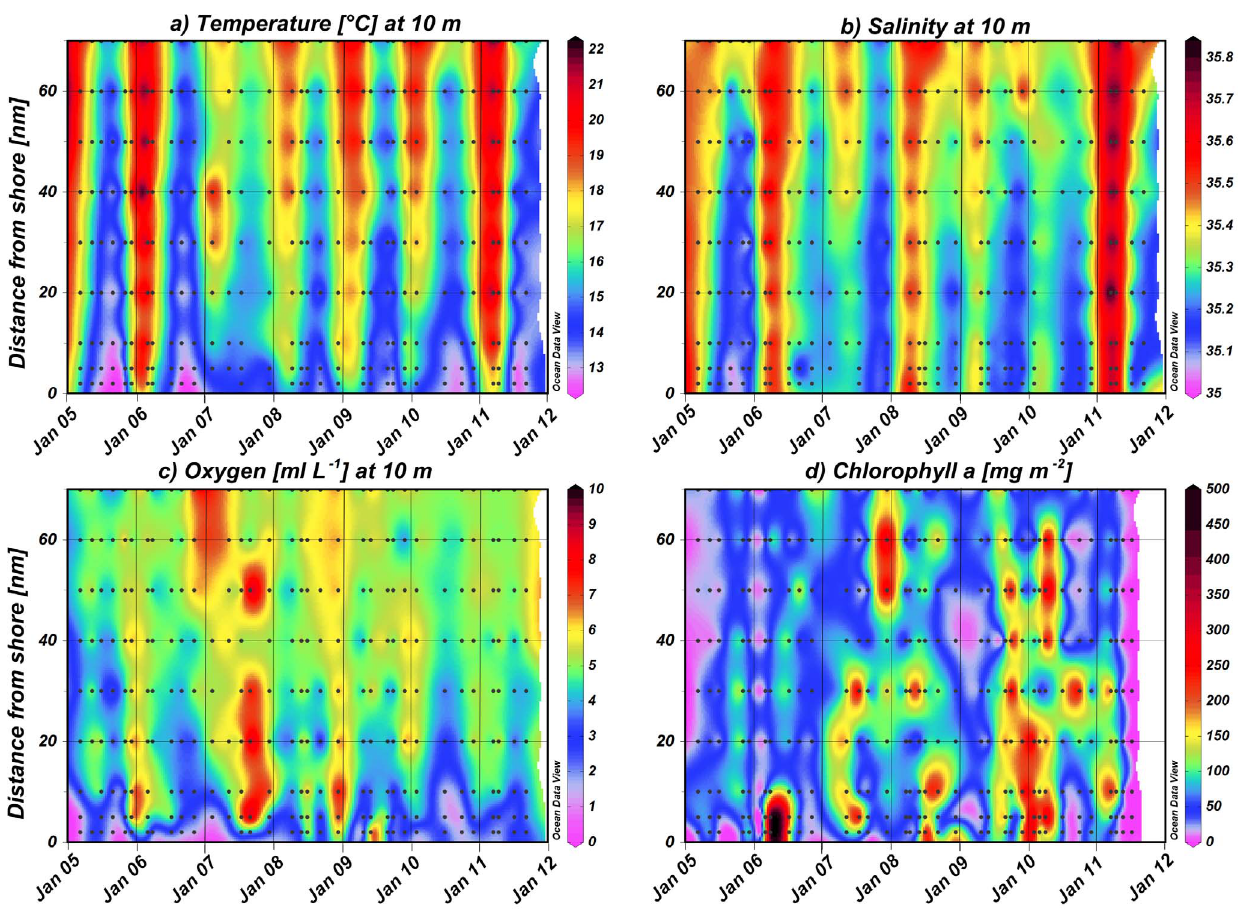
Figure 2. Horizontal and temporal distribution of a) temperature, b) salinity and c) oxygen concentration at 10 m and d) mean chlorophyll a concentration in the upper 30 m along the monitoring line at 20 6 S from March 2005 until September 2011. Black dots represent actual sampling positions and white areas indicate data gaps.